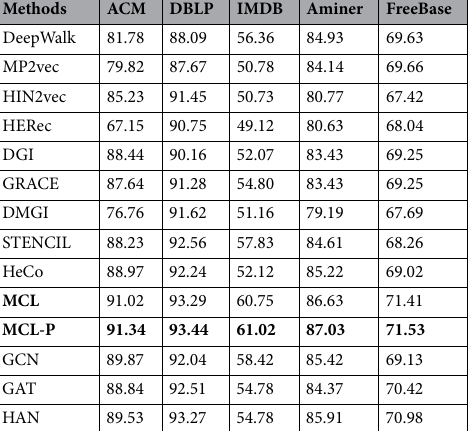
Table 2. Performance of node classification on five benchmark datasets. Boldfaces denote the best performance among self-supervised and supervised methods, respectively. For our model, we use the suffix -P to indicate the positive sampling